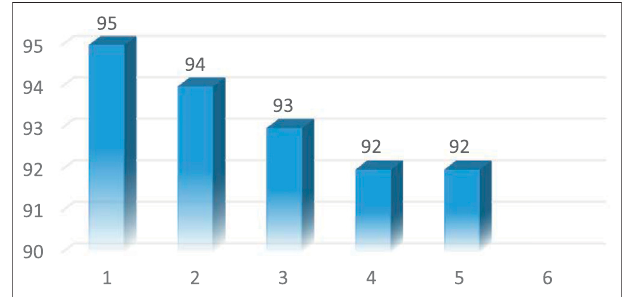
FIGURE 9 | Reusability of Y-MOF in the synthesis of 5f.